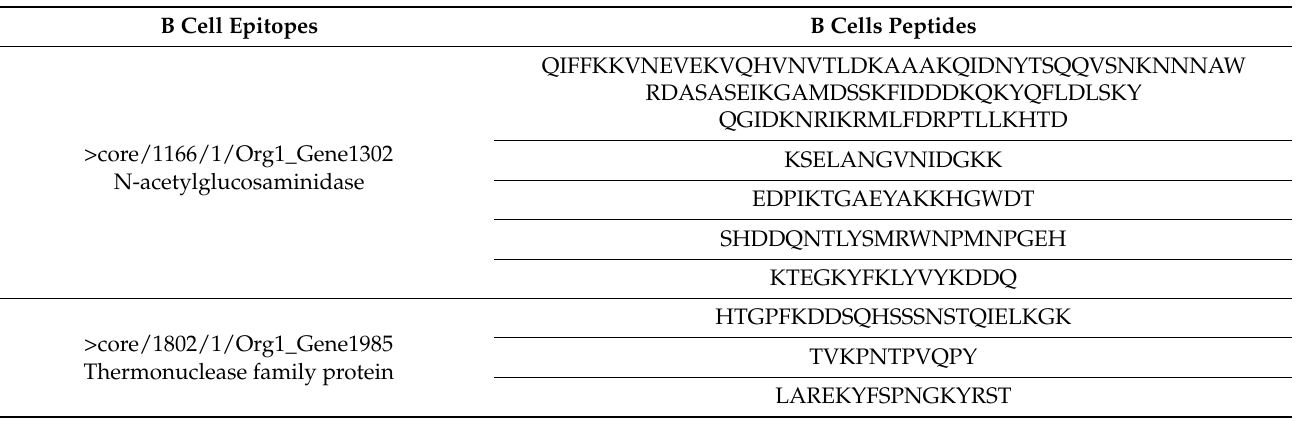
Table 5. Predicted B Cell epitopes.